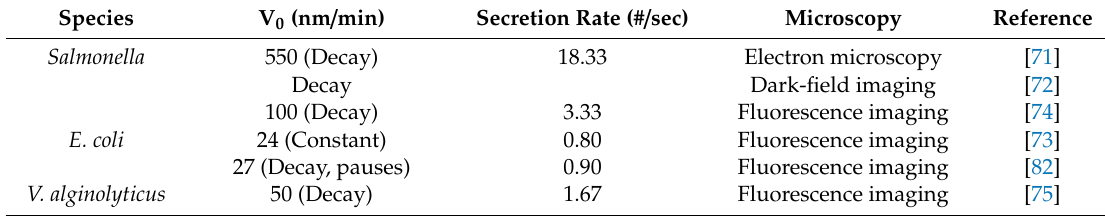
Table 1. Summary of flagellar filament growth in di ff erent